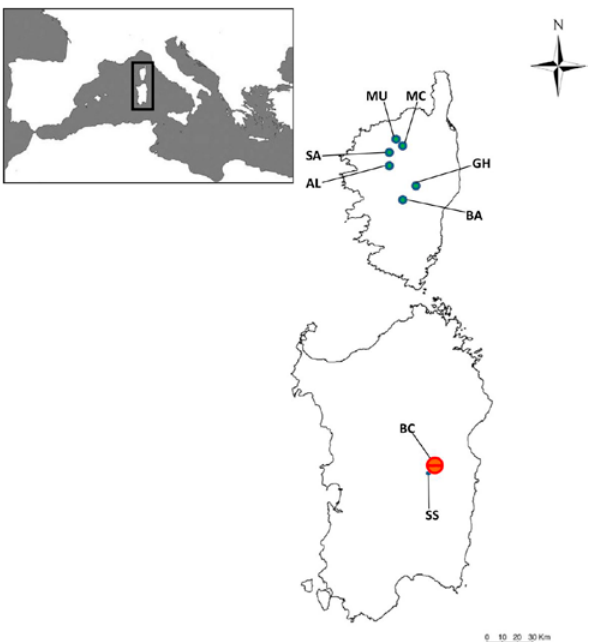
Figure 1. Localities of populations taxonomically assigned to R. cor- sica (green dots) and R. lamarmorae (red dot) sampled for this study. Ruta lamarmorae population was divided in two subpopulations. Detailed information on each population is provided in Table